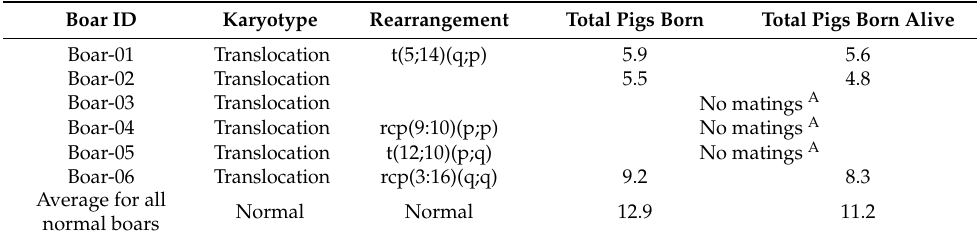
Table 1. Phenotypic performance data (total pigs born and pigs born alive) for boars identified with reciprocal translocations. A Boar had just entered the breeding program, and semen had not yet been used for on-test AI